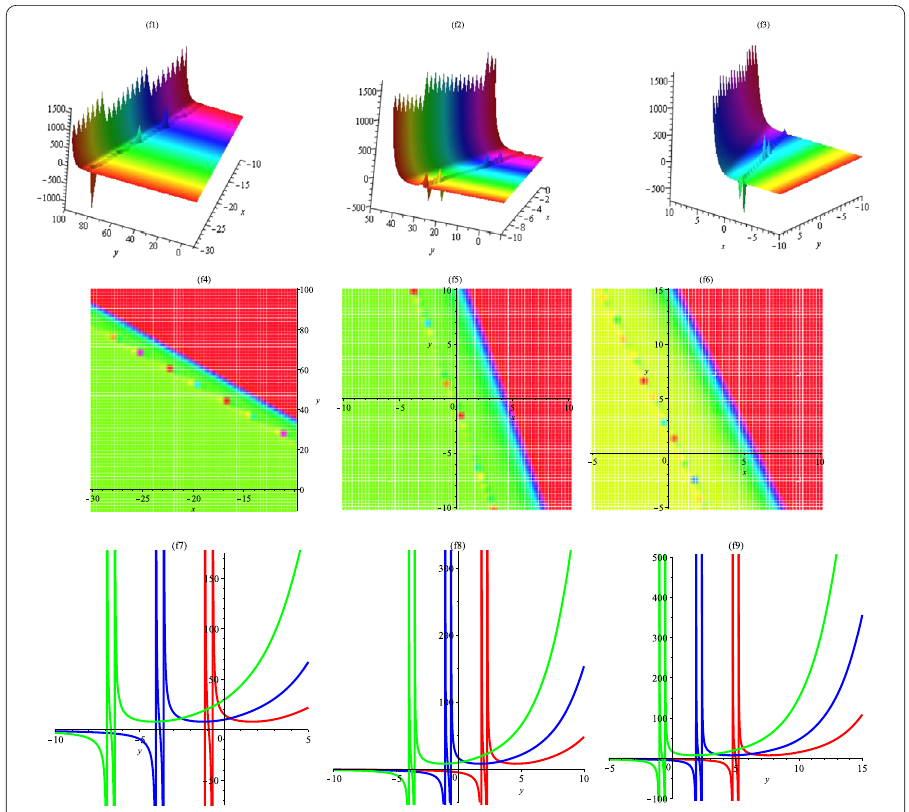
Figure 11 Plots of interaction between 1-lump and 1-stripe solution for (3.6) by taking a = 1, α = 0.1, (cid:14) = 0.3, Ω